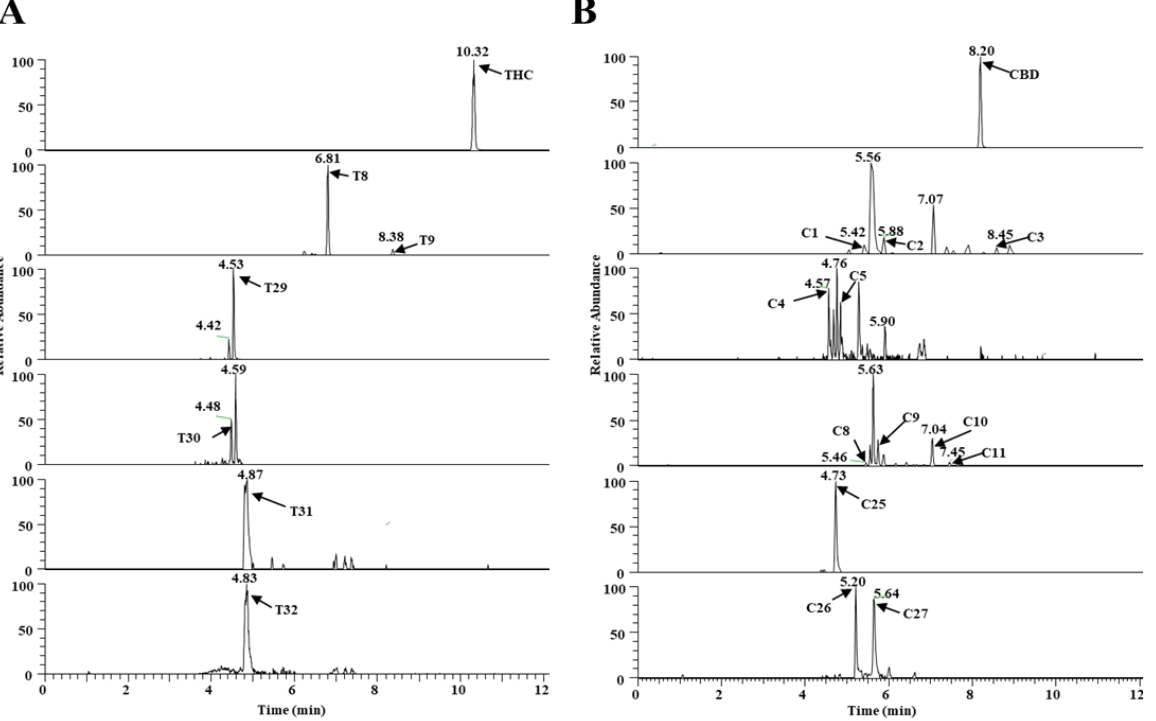
Figure 3. Metabolism of THC and CBD shown in a typical chromatogram of EIC, using UHPLC Q-Exactive MS in vitro. ( A ) THC metabolites (T0, T8, T9, and T29 – T32) and ( B ) CBD metabolites (C1 – C5, C8 – C11, and C25 – C27).